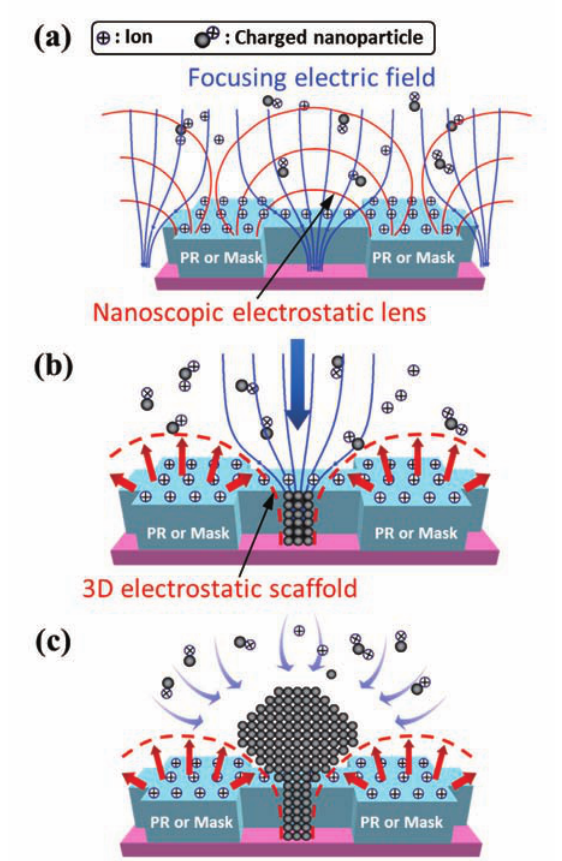
Fig. 3 A schematic illustration of the process to devel- op nanoparticle structures to three-dimensional structures using IAAL. The blue solid lines in- dicate the electric field and the red solid lines indicate the equipotential lines.